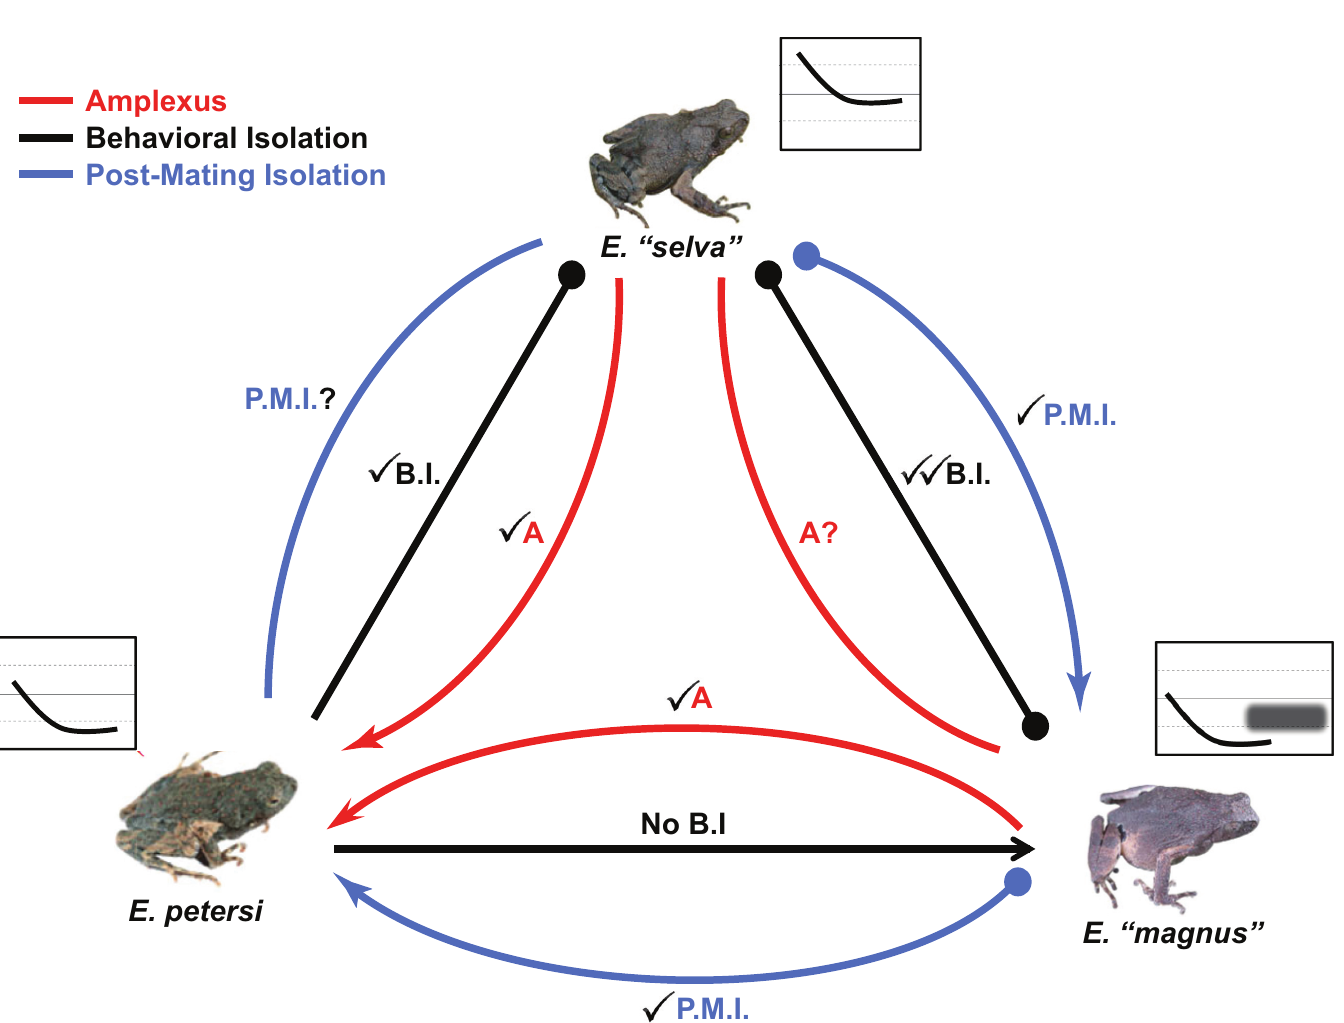
Fig 4. Schematic of species interactions for E . petersi , E . “magnus” and, E . “selva” . Summarizes observations of pairs observedin hybrid amplexus and post-matingisolationresults from the current study, along side previously reportedresults from behavioralisolationtrials (Guerra and Ron, 2008; Boule et al, 2007). Arrows indicate cross directionor high fertilization success. Filled circles indicate direction of rejectionduringbehavioral trials or decreasein fertilizationsuccess (female ! male).